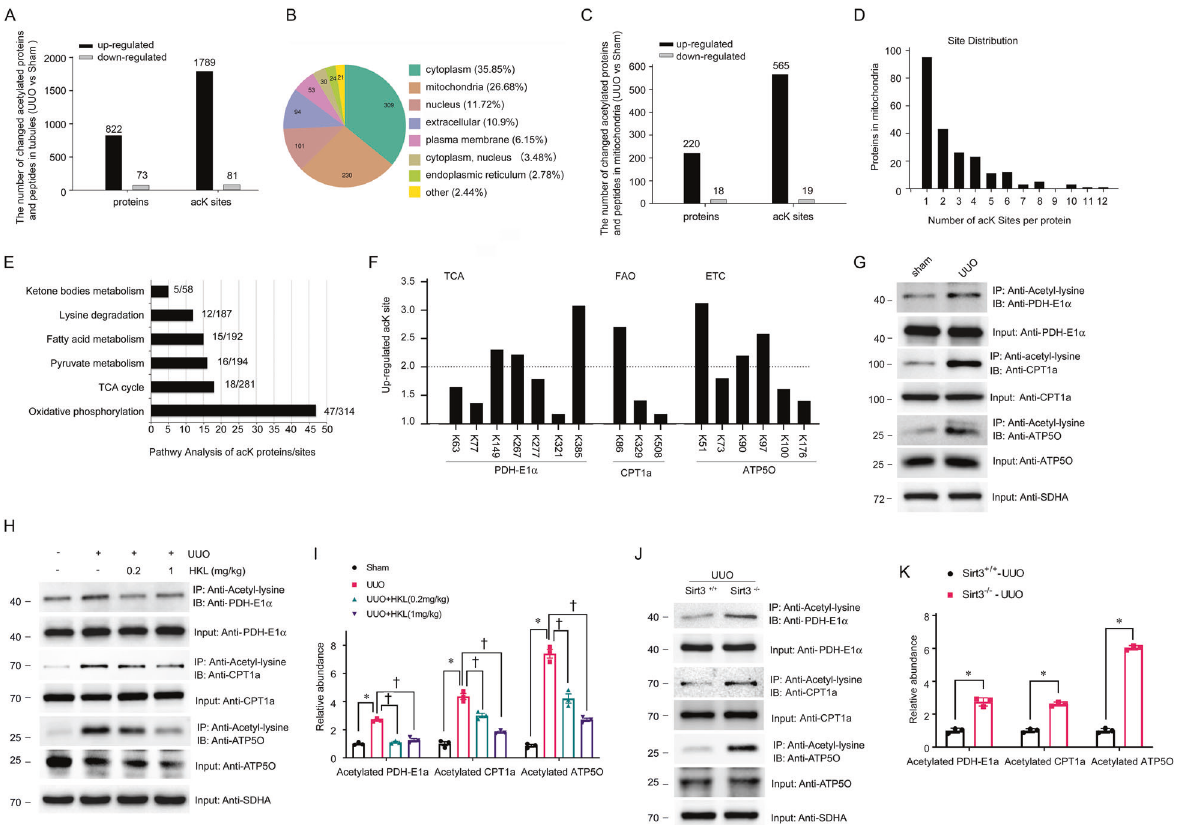
Fig. 5 Loss of SIRT3 results in mitochondrial acetylation in renal fi brosis. A Numbers of upregulated and downregulated acetylated proteins and peptides (UUO vs. Sham). Sites were screened based on twofold change and p < 0.05 in t tests. B Subcellular classi fi cation of changed acetylated proteins. C Numbers of upregulated or downregulated acetylated mitochondrial proteins and peptides (UUO vs. Sham). D Distribution of changed AcK sites per mitochondrial protein. E Pathway of mitochondrial acetylome altered in UUO mice with numbers of proteins and peptides per pathway. F Acetylation pro fi les of PDHE1 α from TCA cycle, CPT1a from FAO, and ATP5O from ETC. G Tubular mitochondria extracts from UUO and sham-operated mice on day 1 immunoprecipitated with anti-acetylated-lysine antibody and analyzed using anti-PDHE1 α , anti-CPT1a, and anti-ATP5O. H , I Tubular mitochondria extracts from UUO and sham-operated mice injected with or without HKL on POD 1 were immunoprecipitated with anti-acetyl-lysine antibody and analyzed with anti-PDHE1 α , anti-CPT1a, and anti-ATP5O. PDHE1 α or CPT1a or ATP5O served as the standard (* P < 0.05, † P < 0.05; n = 3). J , K Tubular mitochondria extracts from Sirt3 KO and WT mice with UUO on POD 1 immunoprecipitated with anti-acetyl-lysine antibody and analyzed using anti-PDHE1 α , anti-CPT1a, and anti-ATP5O. PDHE1 α or CPT1a or ATP5O served as the standard (* P < 0.05; n =